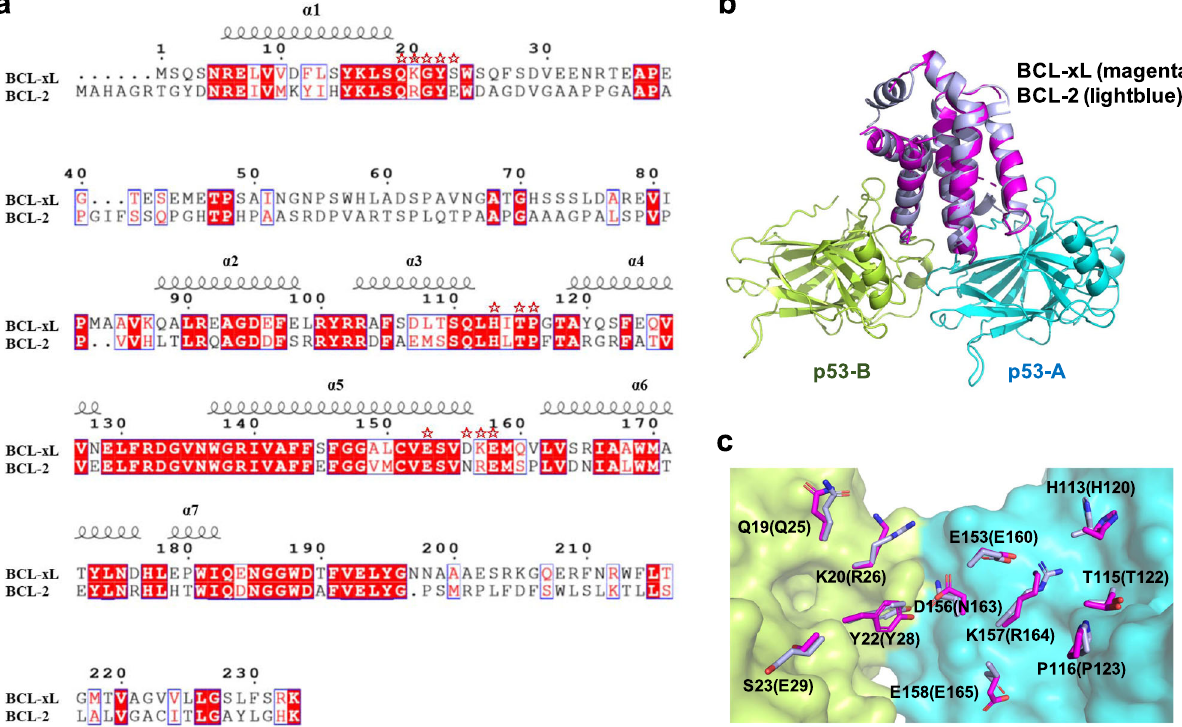
Fig. 6 BCL-2 likely binds p53 in a similar mechanism like BCL-xL. a Sequence alignment of the proteins BCL-xL and BCL-2. The sequence alignment was created using the web services ESPript 3.0. Identical and similar residues are boxed in red and white, respectively. Residues of BCL-xL involved in p53 binding are labeled by red star. b Superposition of BCL-2 structure (PDB: 2XA0) with BCL-xL in our p53/BCL-xL complex. p53/BCL-xL complex is shown as previously. BCL-2 is colored lightblue. c Interfacial residues of BCL-xL and the corresponding residues on BCL-2 (labeled in brackets) are shown as